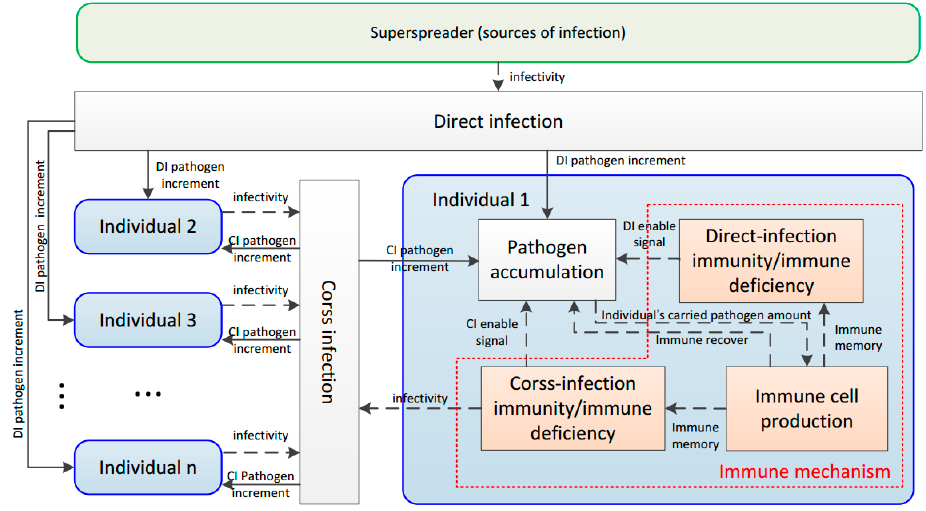
Figure 2. Functional flow process of the proposed biomimetic distributed infection-immunity model (BDIIM) method. (BDIIM)